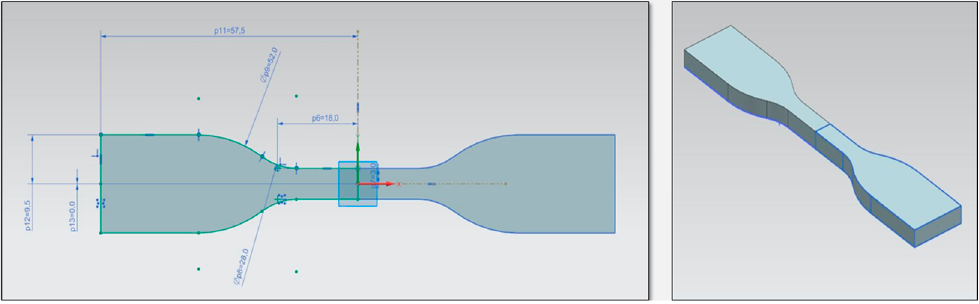
Figure 1. ASTM D638 Type IV.